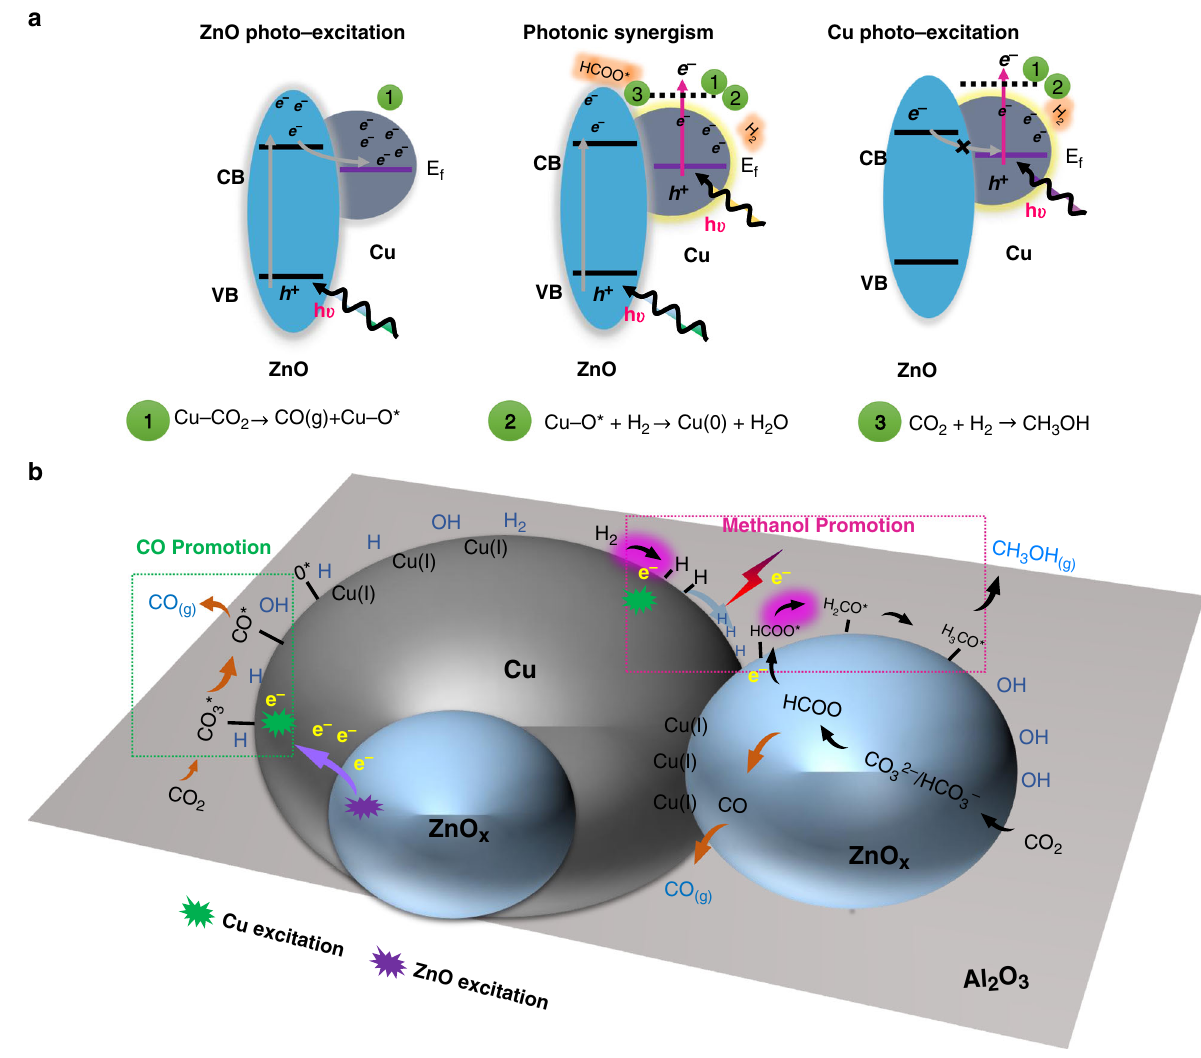
Fig. 6 Proposed light-assisted CO 2 hydrogenation mechanism. a Electron transfer between Cu and ZnO under irradiation by different light spectral ranges. The equations below the schematics indicate the potential reactions which could be improved when interacting with certain light-generated electrons. The potential electron acceptors are highlighted. b The light-aided CO 2 hydrogenation reaction over Cu/ZnO/Al 2 O 3 system. Pathways for CO (chemisorbed CO 2 dissociation or ZnO – HCOO* decomposition) and methanol production (Cu – ZnO interface mediated processes) are illustrated with black and orange arrows, respectively. A dynamic population of species on Cu surface (Cu(I), H*, CO 3 *, CO*), ZnO surface (OH*, CO 3 */HCO 3 *, HCOO*) and Cu – ZnO interface perimeter (HCOO*, H 2 CO, H 3 CO*) under reactive condition are envisioned. The electrons transferred to Cu surface promote CO 2 dissociation to CO (green dotted rectangle), while the light-mediated methanol production is attributed to the promoted H*-supply and HCOO*- hydrogenation (glowing dark arrow) at the Cu – ZnO interface perimeter (red dotted rectangle) under dual excitation of Cu and